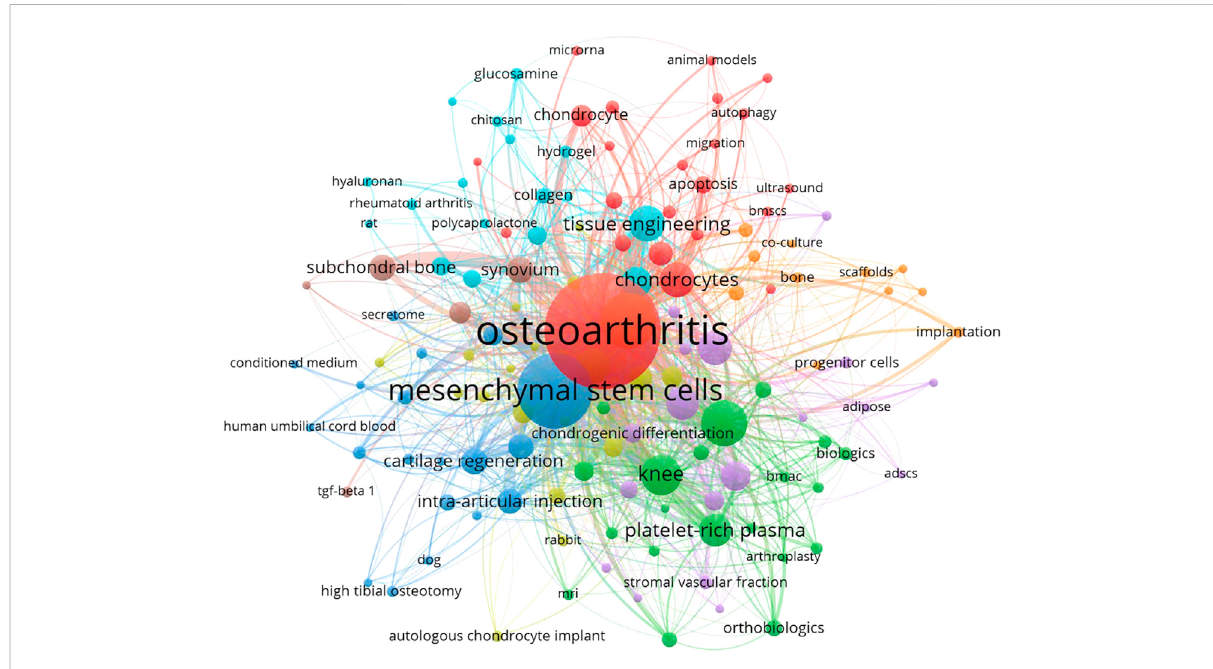
FIGURE 6 Co-occurrence analysis of all keywords regarding stem cell therapy for KOA research. Colors indicate different clusters.